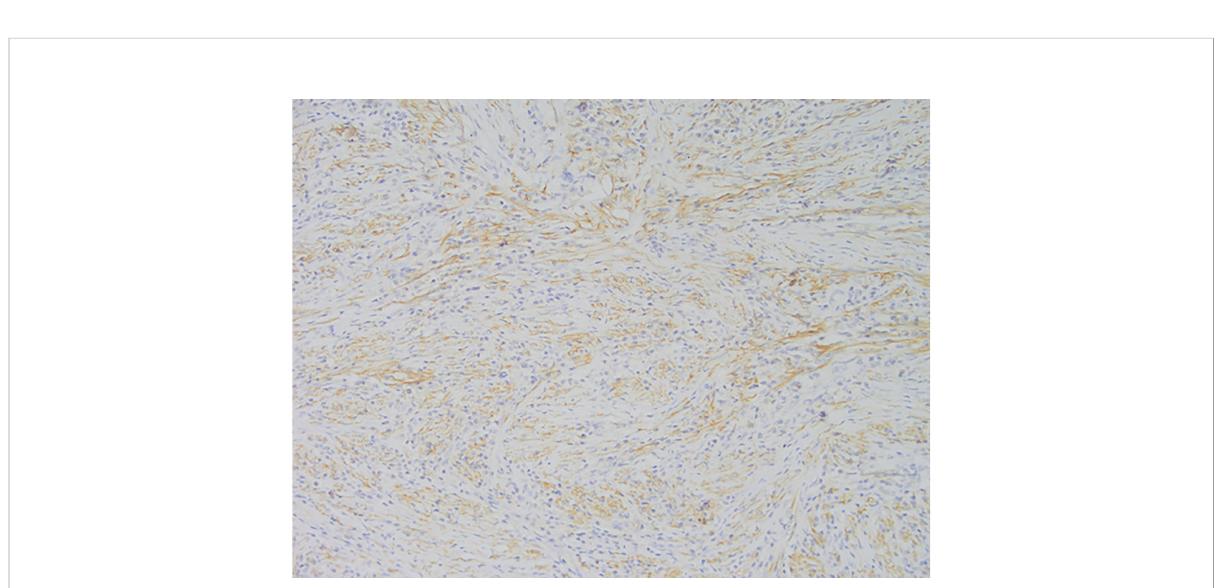
FIGURE 4 Representative image of anaplastic lymphoma kinase (ALK) expression (magni fi cation,